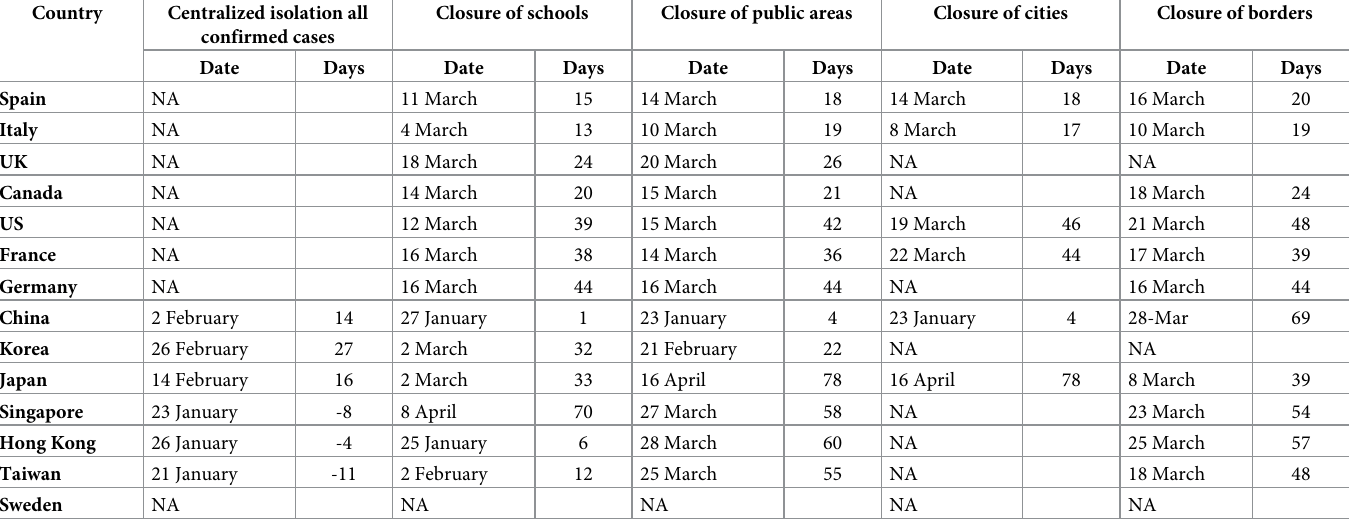
cases of COVID-19, together with the analysis of the 33 rd day when Japan closed its schools. We evaluated Singapore’s data on the 58 th day when they closed their public areas and the 70 th day when they closed their schools. Exceptionally, we analyzed the 12 th day as Taiwan initiated opening their schools and the 55 th day when they closed their public areas. Hong Kong, Singa- pore, and Taiwan were not analyzed for the effect of centralized isolations of all confirmed cases because the pre-intervention time was too short. Sweden was excluded from all of the above control measures since this country denied to against the virus. The date of implementa- tion of the national intervention at the moment of the 10th confirmed cases is outlined in Table 1. And its reference link is presented in S7 Table. Table 2 showed that when the above countries applied neither methods a,b,c,d,e , pre-inter- vention new case indices [100% x (new cases/active cases)] ranged from 12.60% to 25.98%. At